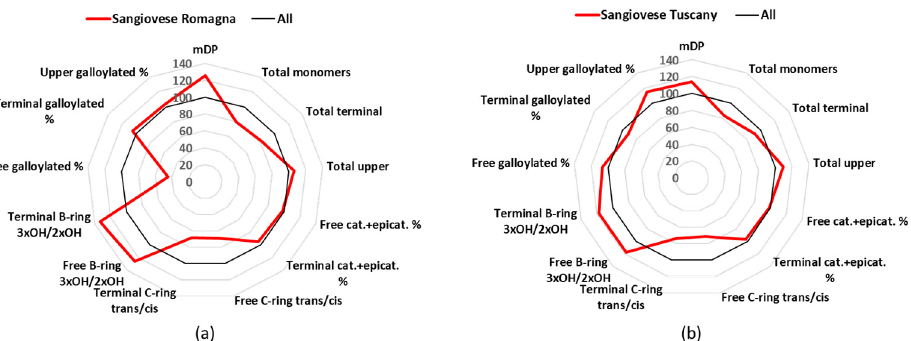
Figure 3. Radar graph comparing the percentage of the relative mean values of Sangiovese wines from Romagna ( a ) and from Tuscany ( b ), with the mean values of the 12 groups considered as 100%. cat.: catechin, epicat: epicatechin. Table 1. Basic statistics (mean ± SD) and post-hoc ANOVA of the mDP values. Wine Group (Number of Samples per